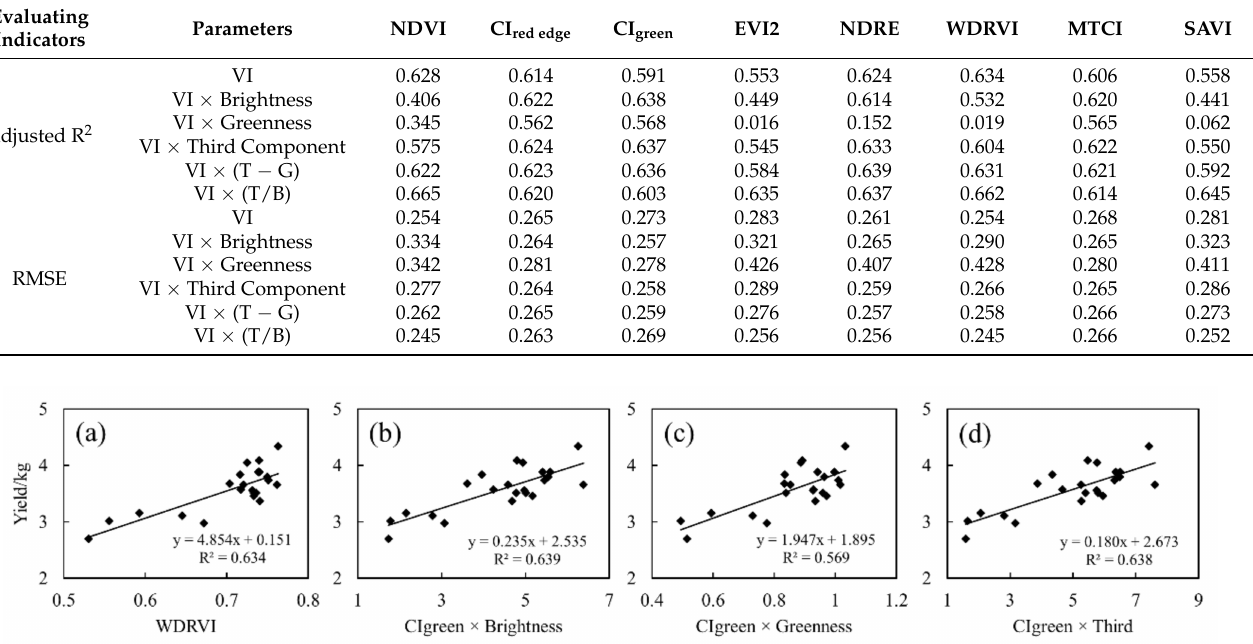
Figure 8. Well-performing yield-estimation models incorporating TCT parameters and VIs at the booting